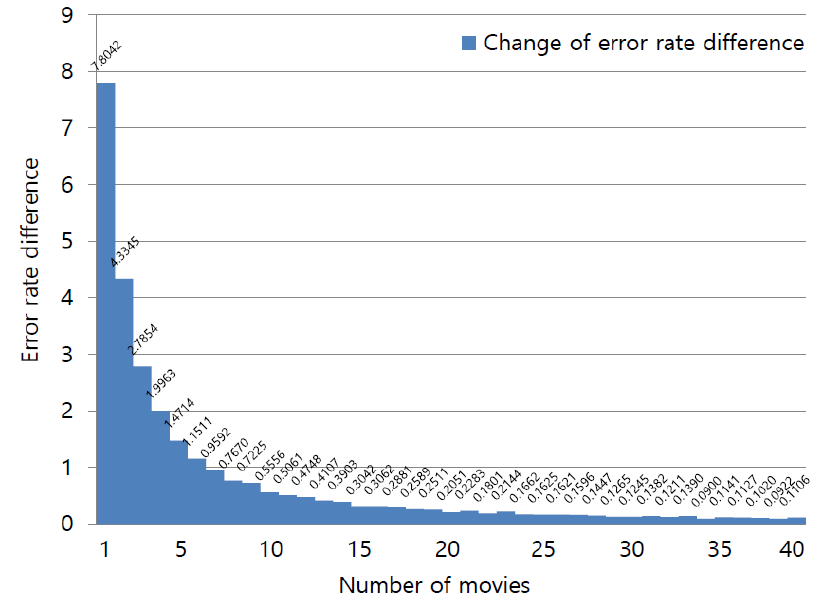
Figure 18. Rates of decrease in error rates.